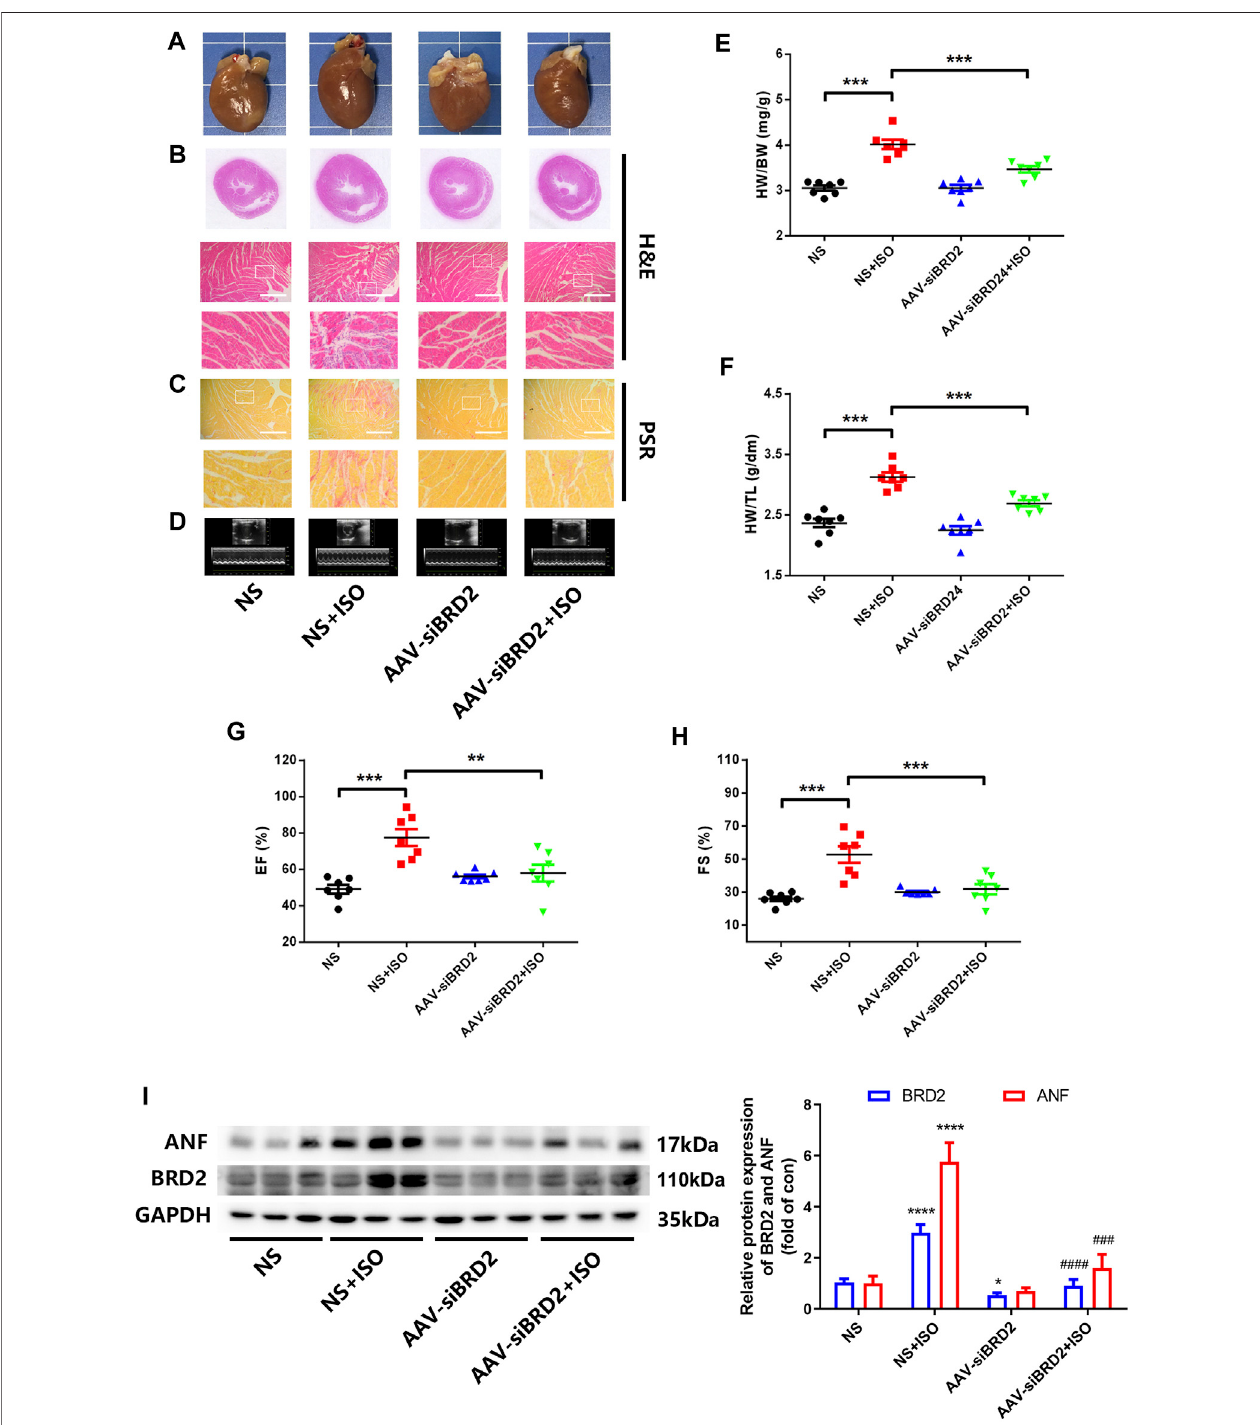
FIGURE 3 | BRD2 knockdown protected SD rats from ISO-induced cardiac hypertrophy. SD rats received intramyocardial injections of adeno-associated virus encodingsiBRD2orsi-NC,followedbysubcutaneousinjectionofISO(1.2 mg/kg/d)oranequalvolumeofnormalsaline(NS)2 weeksafteroperationfor7 days.Hypertrophic changes of left ventricle were observed by (A) gross morphologic examination and (B) H&E staining, (C) PSR staining and (D) echocardiography. Scar bar: 50 μ m. Post- mortem measurements of (E) heart weight/body weight (HW/BW) and (F) heart weight/tibia length (HW/TL) values. Echocardiography measurements of (G) ejection fraction(EF, %)and (H) fractionshortening(FS, %)values. (I) TheproteinexpressionofBRD2andANFmeasured byWesternblot. Thedataarepresented asmean±SEM, * p < 0.05,** p < 0.01,*** p < 0.001 vs .control.**** p < 0.0001 vs. control. # p < 0.05, ## p < 0.01, ### p < 0.001 vs. ISO, ### p < 0.001 vs. ISO, #### p < 0.0001 vs. vs.ISO. n =7.